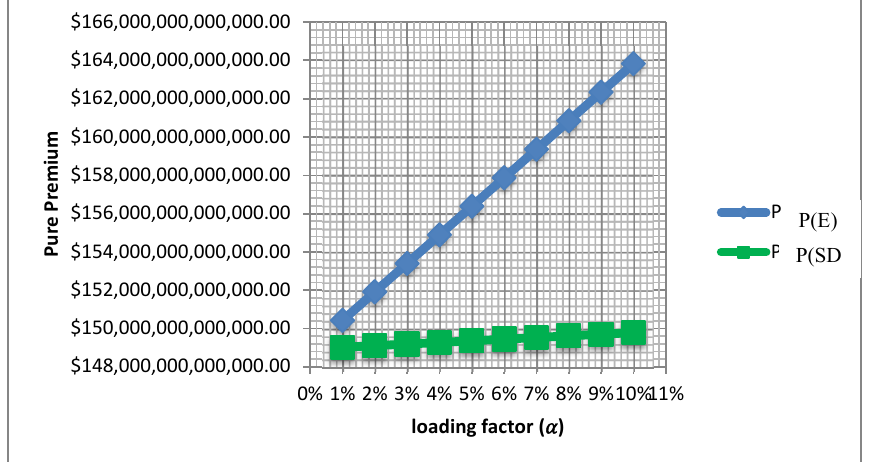
Fig. 5. Comparative analysis of premium calculation with the principle of expected value and standard deviation Fig. 5 shows the determination of natural disaster insurance premiums with the principle of expected value, and the value continues to increase along with the increase in the given cost factor. The principle of standard deviation continues to increase along with the increase in the given cost factor. However, the delta (difference) of the premium based on the increase in the value of the cost factor from the expected value principle is very large compared to the standard deviation principle. In addition, based on Fig. 5, it can be seen that the principle of standard deviation has natural disaster insurance premiums that are cheaper or smaller than the principle of expected value at the same cost factor. In this case, the principle of standard deviation is very suitable to be used in the calculation of natural disaster insurance premiums. It is also